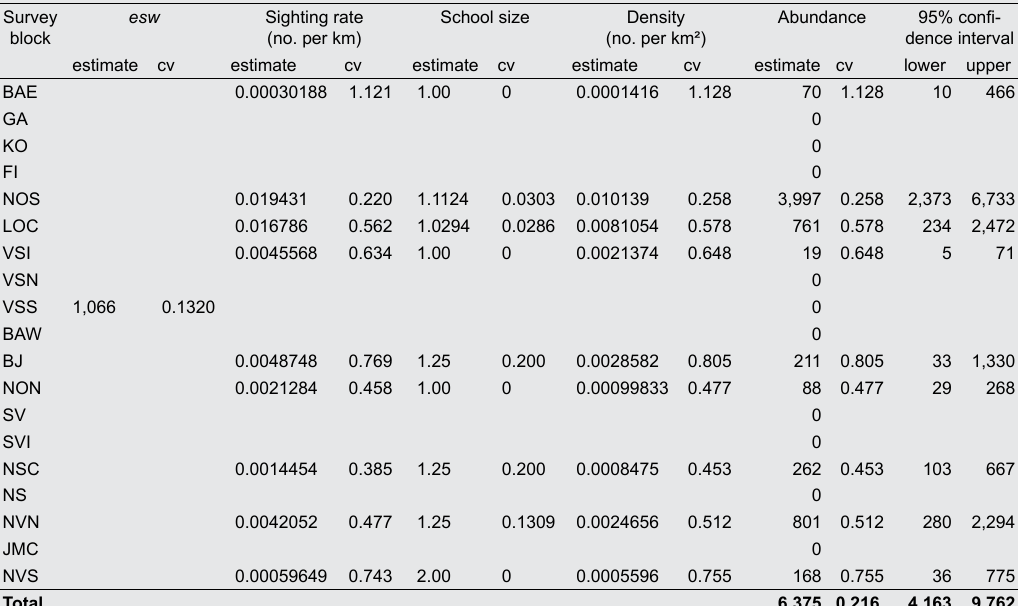
Table 11. Estimated abundance for sperm whales for the shipboard surveys 1996-2001, based on the combined data from plat- forms 1 and 2. Survey esw Sighting rate block (no. per